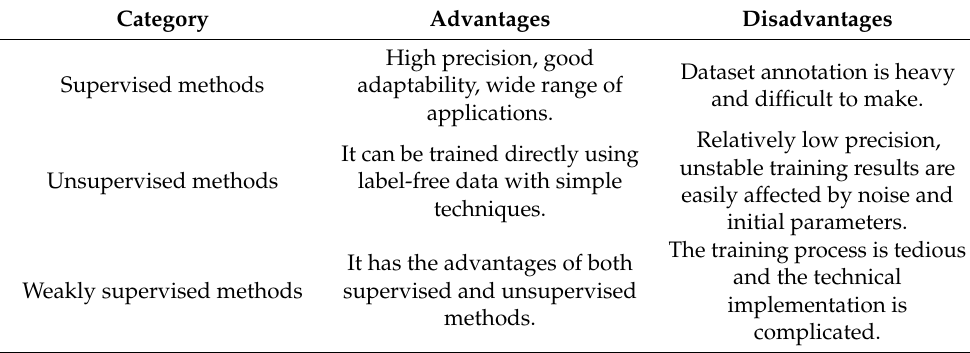
Figure 8. Diagram of the outline of the deep learning methods. Table 4. Summary of the features of deep learning